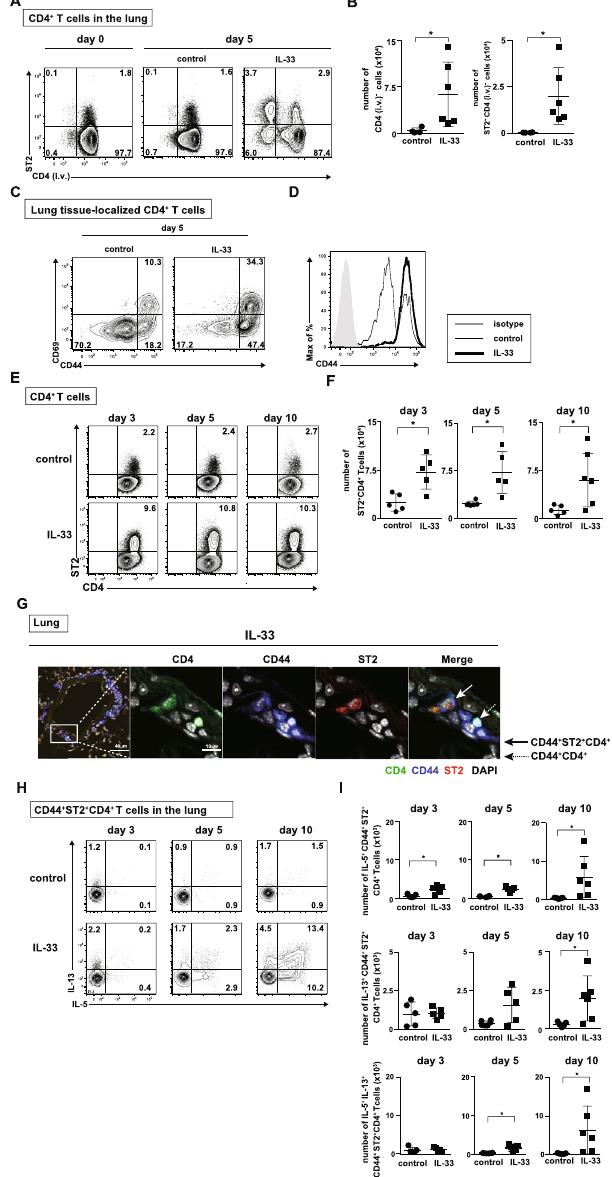
Figure 1. IL-33 induced increased expression of ST2 in lung tissue-localized memory-type ST2 + CD4 + T cells along with enhanced production of IL-5 and IL-13. IL-33 or saline (control) was administered intratracheally to BALB/c mice on Day 0, and the indicated assays were performed on Day 3 to 10. ( A ) To distinguish lung tissue-localized CD4 + T cells and blood-borne CD4 + T cells, anti-CD4 antibody was injected intravenously and analyzed three minutes later. In the CD4 + T cells in the lung, injected antibody-unstained cells (CD4 (i.v.) − cells) indicate lung tissue-localized CD4 + T cells. Representative flow cytometry plots of ST2 + CD4 (i.v.) − CD4 + T cells in the lung at the indicated time points. ( B ) Absolute numbers of CD4 (i.v.) − CD4 + T cells (left panel) and ST2 + CD4 (i.v.) − CD4 + T cells (right panel) in the lung from the two groups at day 5 are depicted. ( C ) Representative flow cytometry plots of lung tissue-localized CD4 + T cells in the lung at day5 after saline (control) or IL-33-admnistration are depicted. ( D ) The histogram represents the expression of CD44 on lung tissue-localized CD4 + T cells. ( E ) Representative flow cytometry plots of ST2 + CD4 + T cells in the lung at the indicated time points. ( F ) Absolute numbers of ST2 + CD4 + T cells in the lung from two groups at the indicated time points are depicted. ( G ) Representative confocal microscopic pictures of lung tissue stained with anti-CD4 (green), anti-CD44 (blue), and anti-ST2 (red) are shown. The solid arrow indicates CD44 + ST2 + CD4 + T cells, and the dotted arrow indicates CD44 + CD4 + T cells. Scale bars, 40 μ m and 10 μ m. ( H ) Representative intracellular staining profiles of IL-5 and IL-13 are shown on CD44 + ST2 + CD4 + T cells. ( I ) Absolute numbers of the indicated cytokine producing-CD44 + ST2 + CD4 + T cells in the lung from the two groups at the indicated time points are depicted. The mean values ± SD are shown for five to six mice in each group. Three independent experiments were performed with similar results ( A–I) . control: saline-treated mice, IL-33: IL-33-treated mice, * p < 0.05; Mann-Whitney U